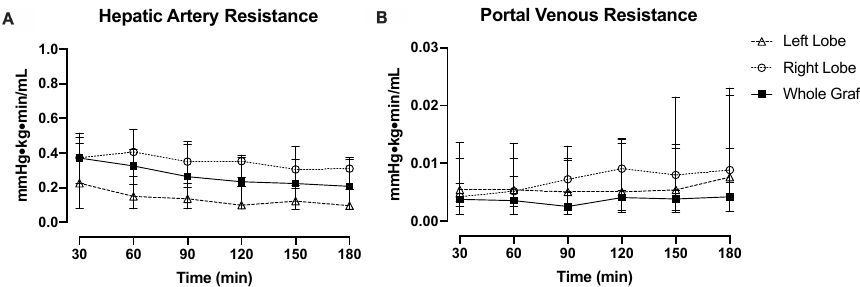
Figure 2. Median vascular resistance of splits lobes during perfusion is statistically the same. ( A ) Hepatic arterial resistance was qualitatively higher in the right lobes compared with the left lobes, though did not reach statistical significance at any time point. Interestingly, whole-graft arterial resistance was approximately the average of the individual lobes. ( B ) Split right lobes tended to have higher portal venous resistance during perfusion compared with left lobes (not significant throughout), while whole grafts had lower overall portal venous resistance than individual split lobes.